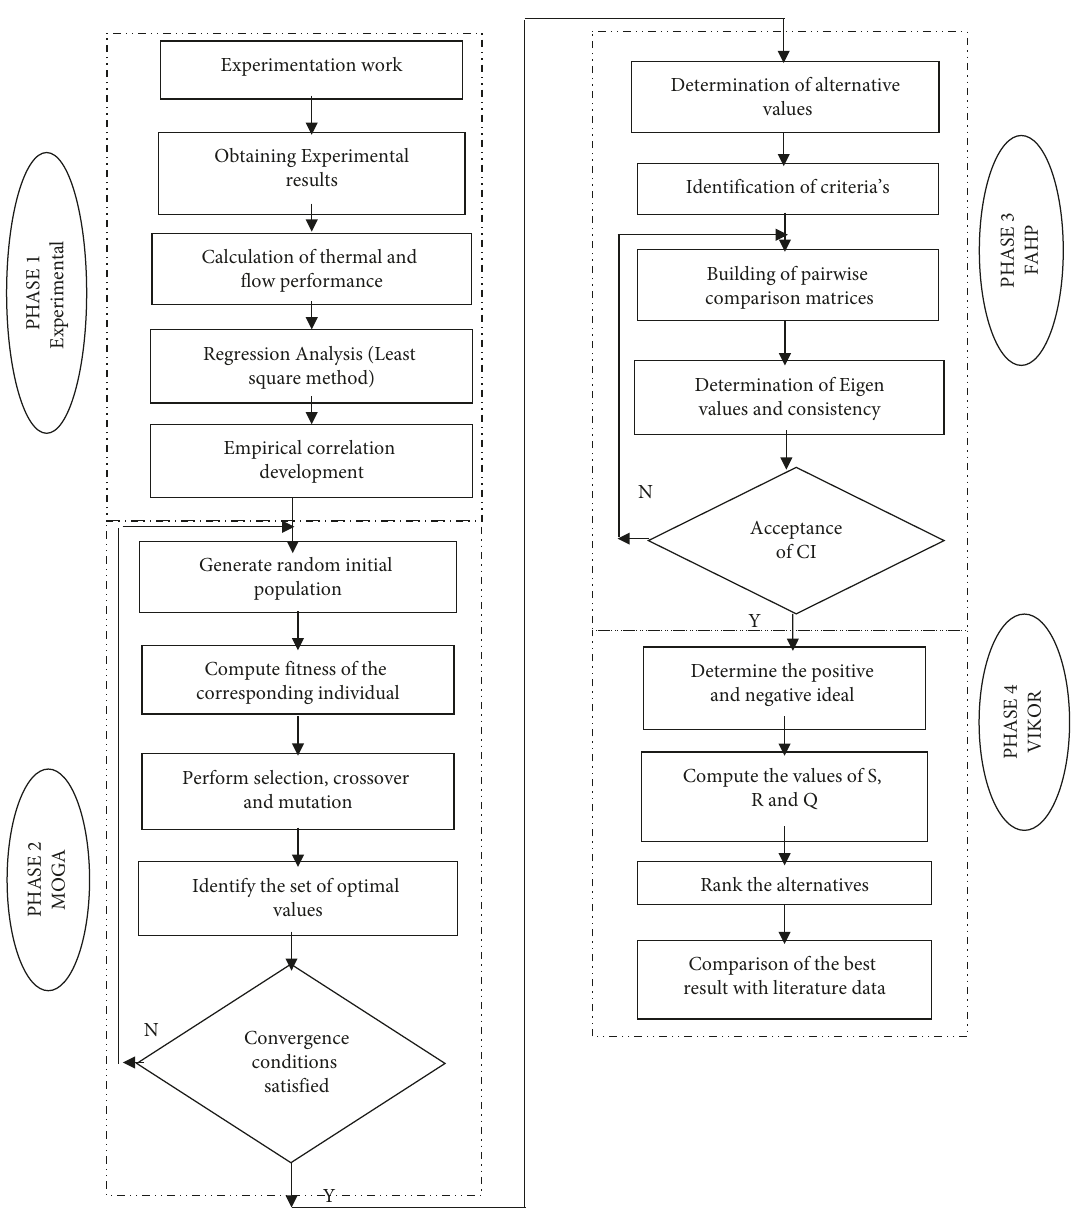
Figure 1: Phases of evaluation